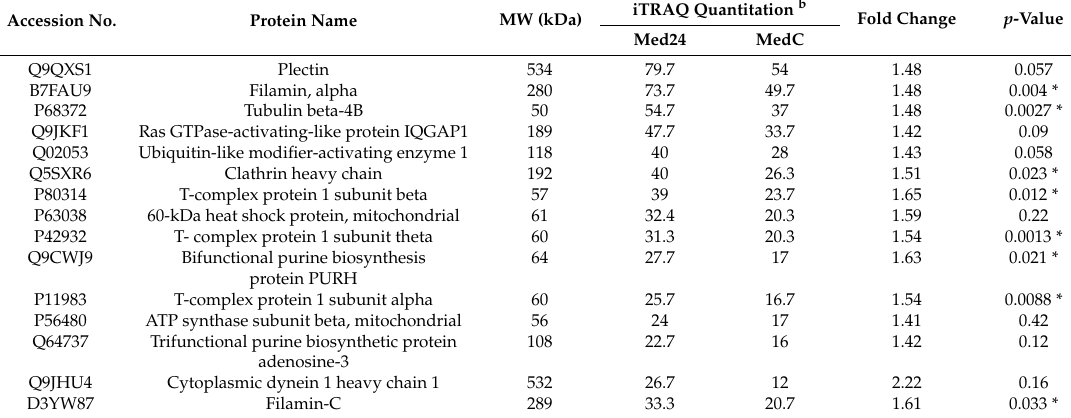
Table 1. Up-regulated proteins in the abundance group of secretomes a . a Proteins up-regulated by more than 1.4 fold by the strain RH2 infection are listed. b Mean of three assessments. * p < 0.05. Accession